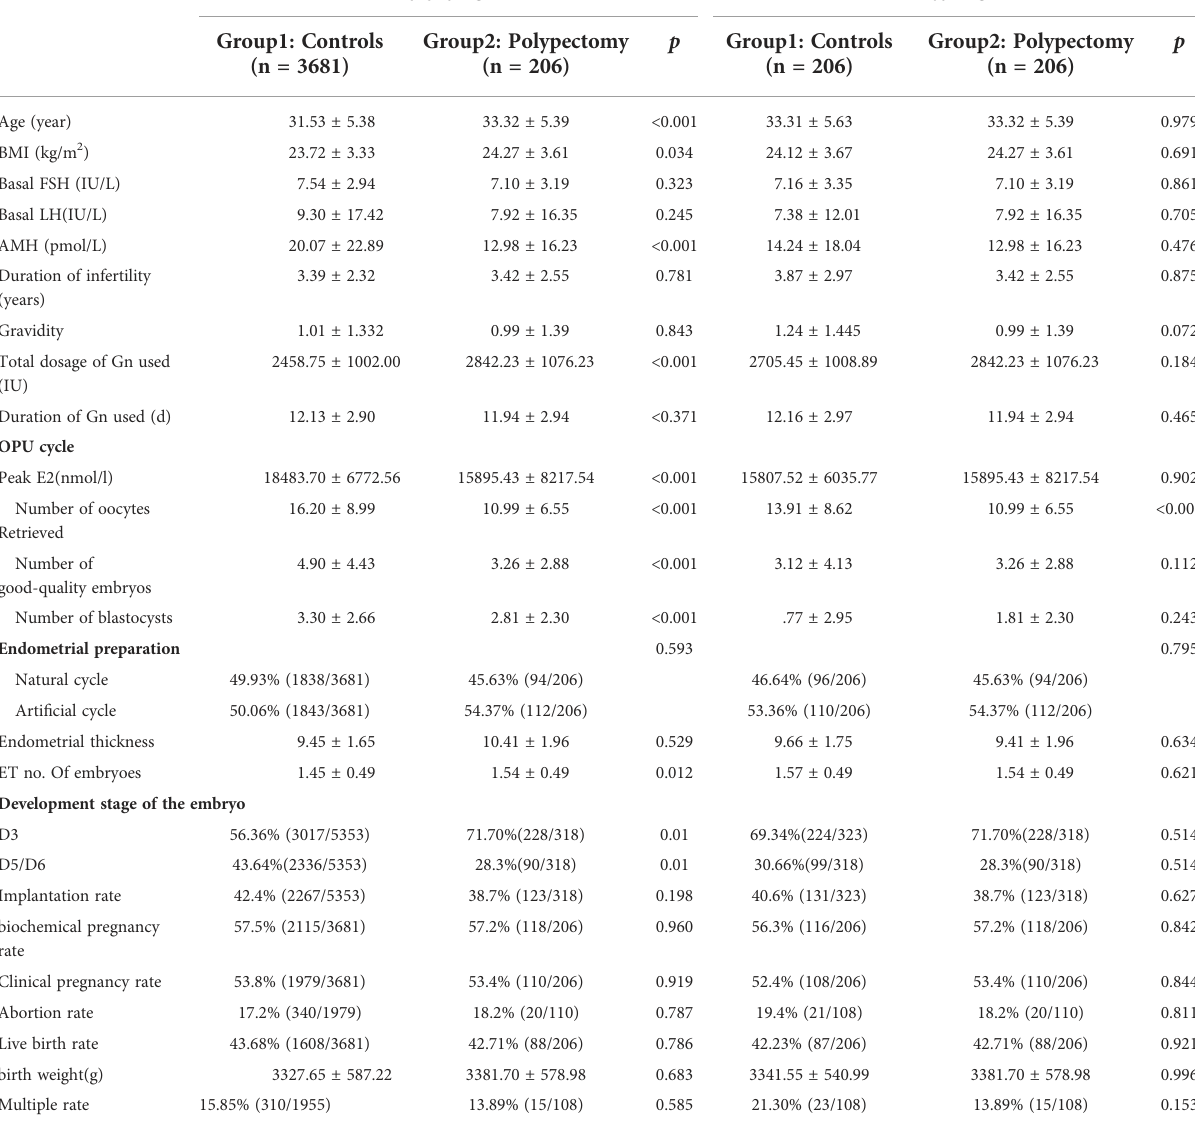
TABLE 1 Baseline characteristics of all patients. Before PSM After